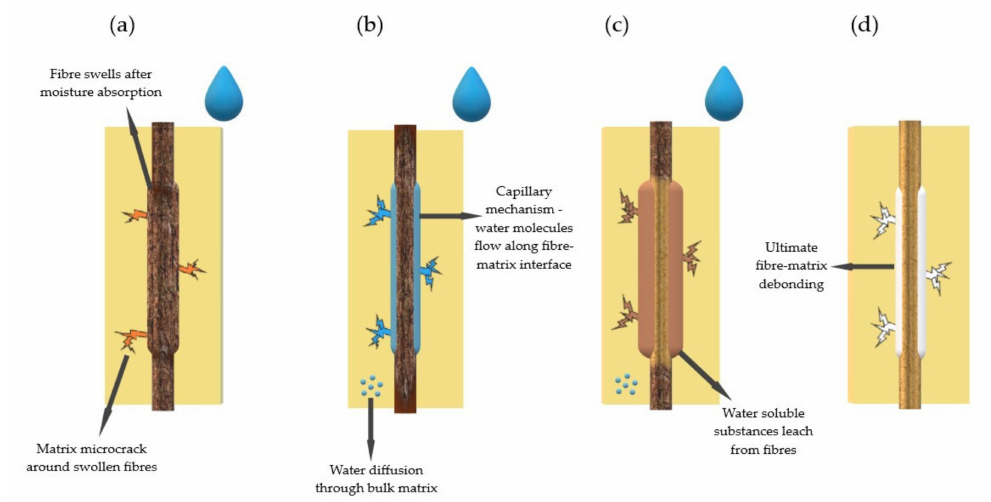
Figure 5. Degradation during the immersion test. Effect of water penetration into the fiber–matrix composite: ( a ) Moisture sorption; ( b ) capillary mechanism; ( c ) substance leaching from fiber; ( d ) fiber–matrix